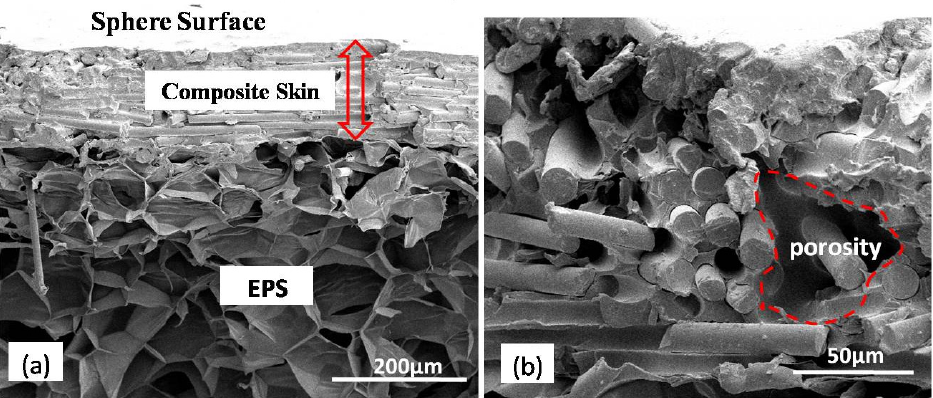
Figure 4. The cross-section appearance of the CF/phenolic resin shell before carbonization: ( a ) Typical structure; ( b ) Magnified image of the CF/phenolic resin composite shell.